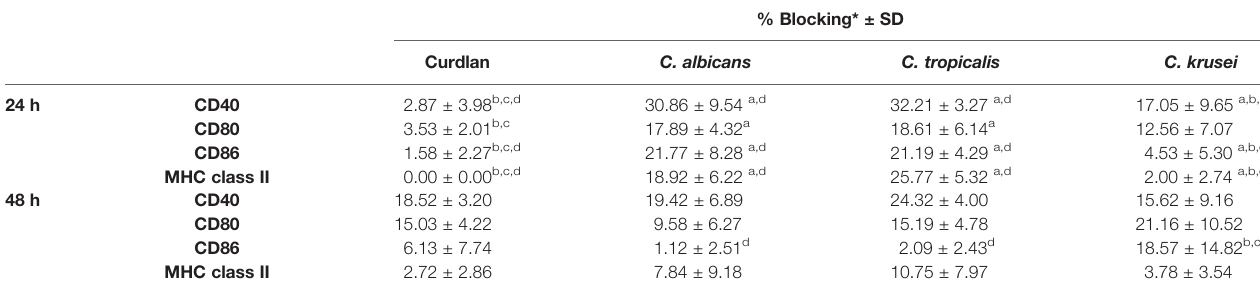
TABLE 1 | Blockade of dendritic cell (DC) maturation by dectin-1 antagonist.